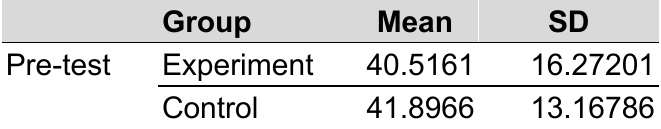
Table 3. Mean score of pre-test between experiment and control class